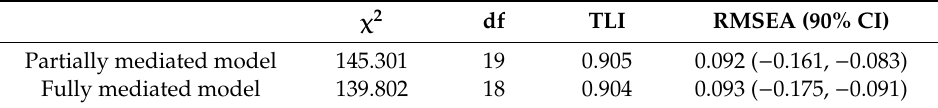
Table 11. Path coe ffi cients of mediated